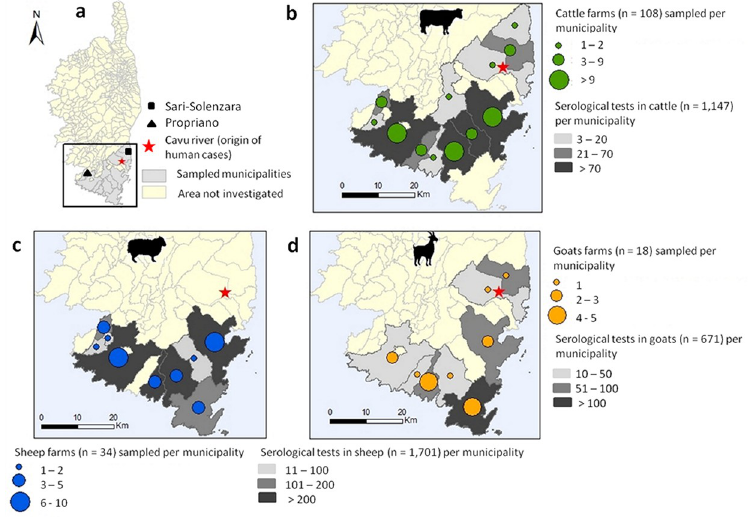
Fig 1. Mapping of the sampling area in south Corsica (a) and distribution of the sampled cows (b), sheep (c) and goats (d). This map was made using QGIS 3.4.1 using open shapefile map of the Corsica